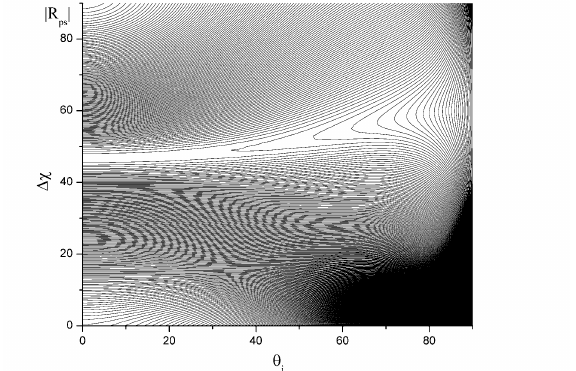
Fig. 7. The dependence of the modulus of the amplitude reflection coefficient R ps on the angle of  and the torsion angle  incidence i